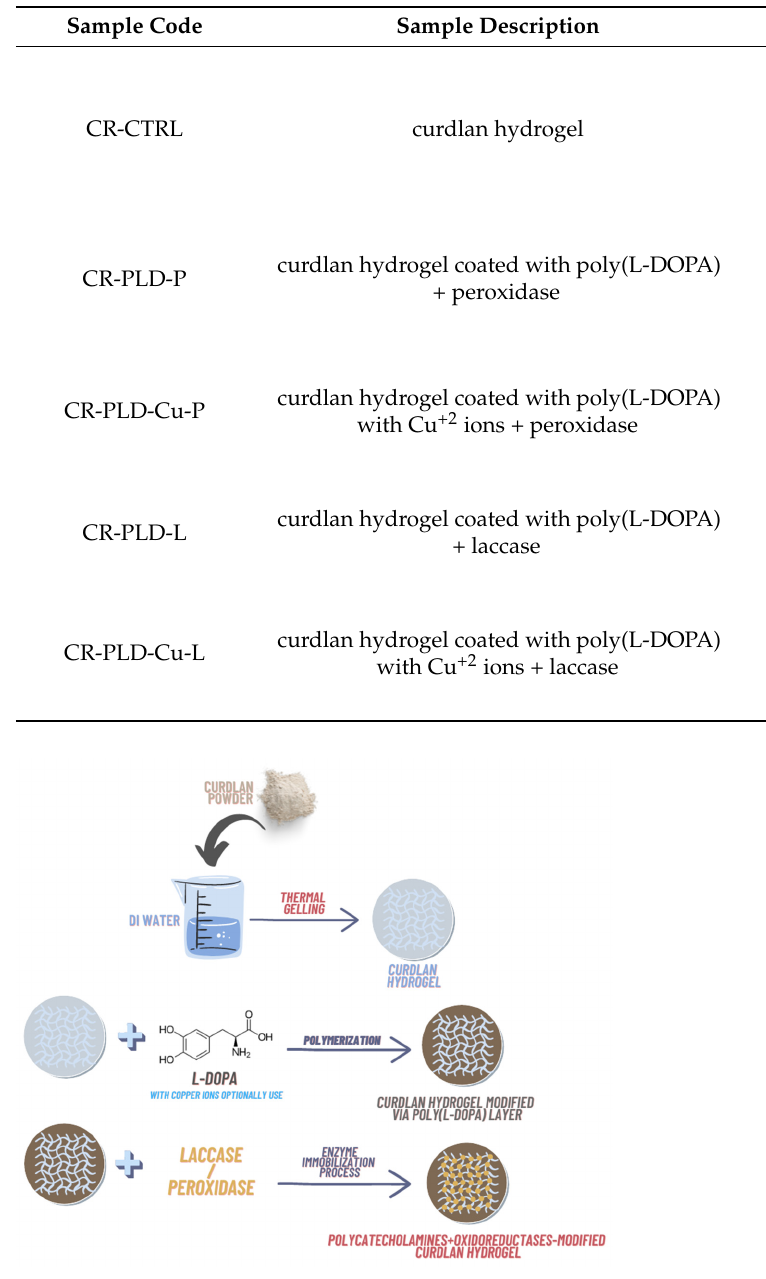
Figure 1. Scheme of hydrogels synthesis.